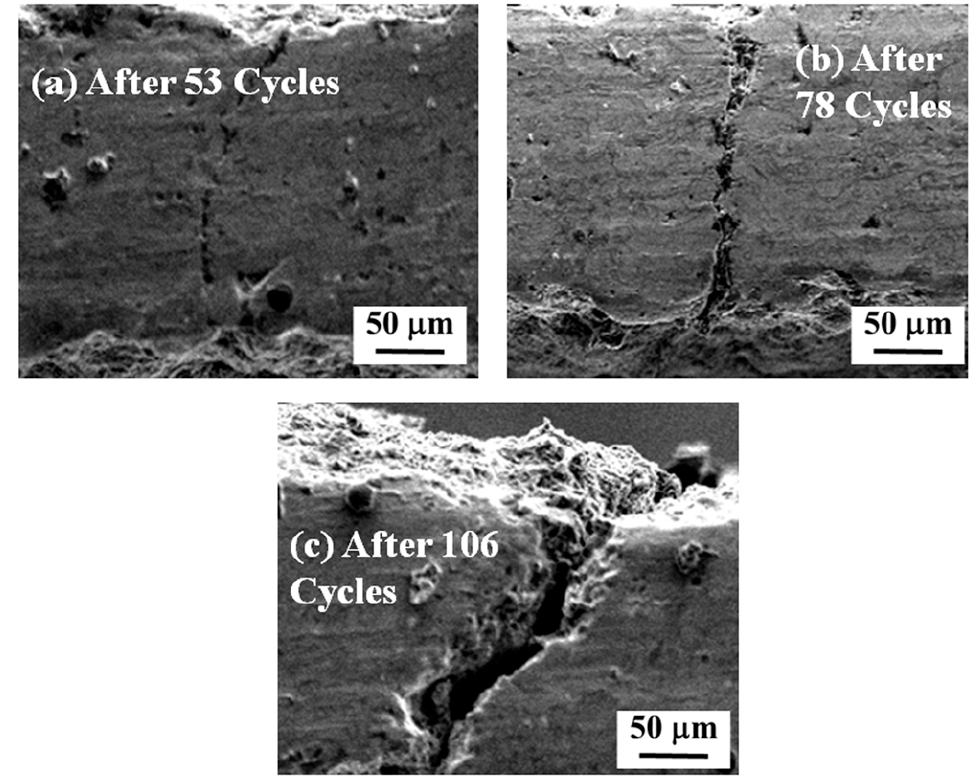
Figure 12. SEM images of as-sprayed FG-TBC after ( a ) 53, ( b ) 78 and ( c ) 106 cycles. In TBCs, there are two different crack propagation mechanisms: (i) cracks that prop- agate along the coated surface, i.e., parallel to the coated surface, termed inter-splat cracks; and (ii) cracks that are oriented across the thickness of coatings, i.e., perpendicular to the coated surface, termed intra-splat cracks [27,56]. Reports have shown that parallel